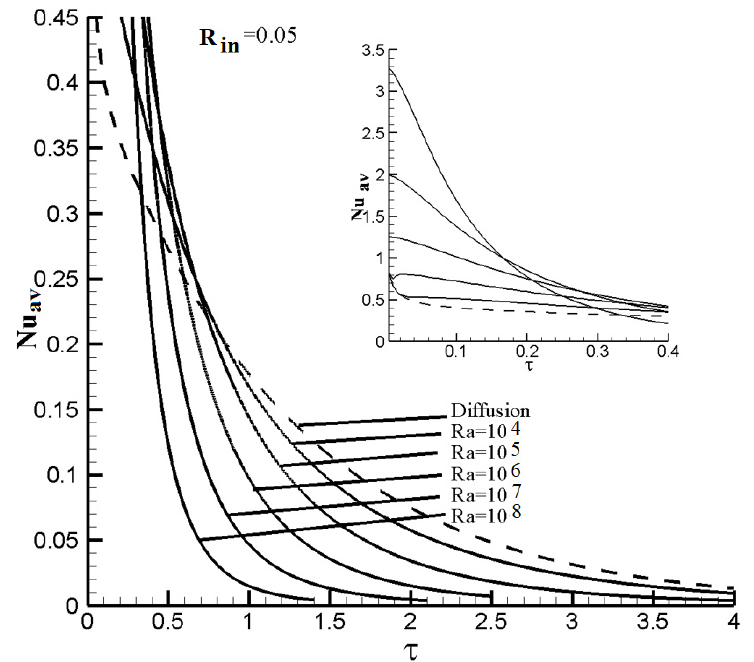
Figure 5. Nusselt number as a function of time for different Ra and for R in = 0.05.